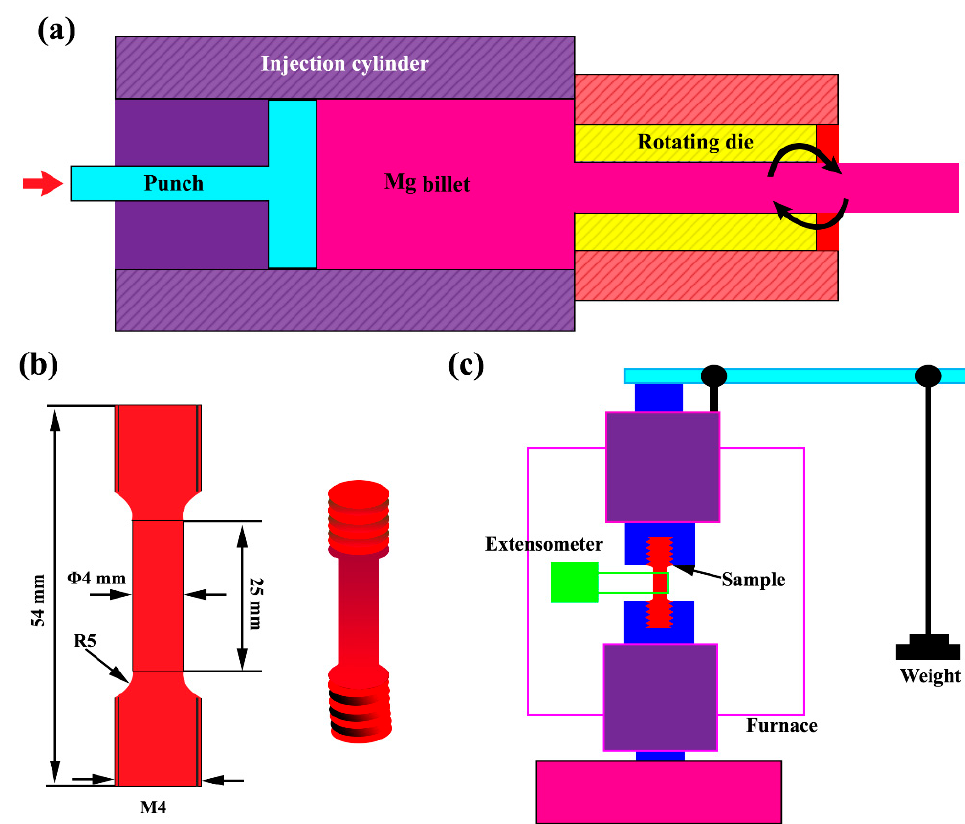
Figure 1. Schematic of the: ( a ) KoBo extrusion method, ( b ) creep sample, and ( c ) creep setup. Table 1. Mechanical properties and grain size of the KoBo extruded and aged